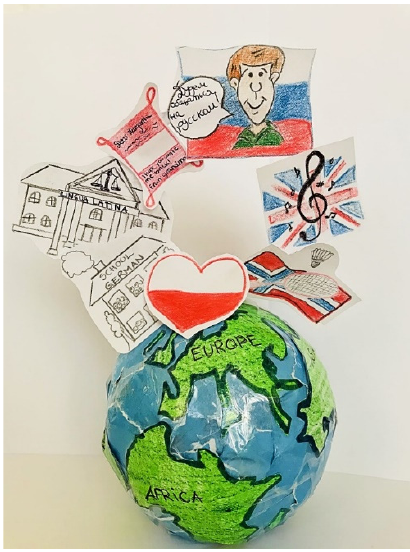
Figure 8. ST13’s DLC